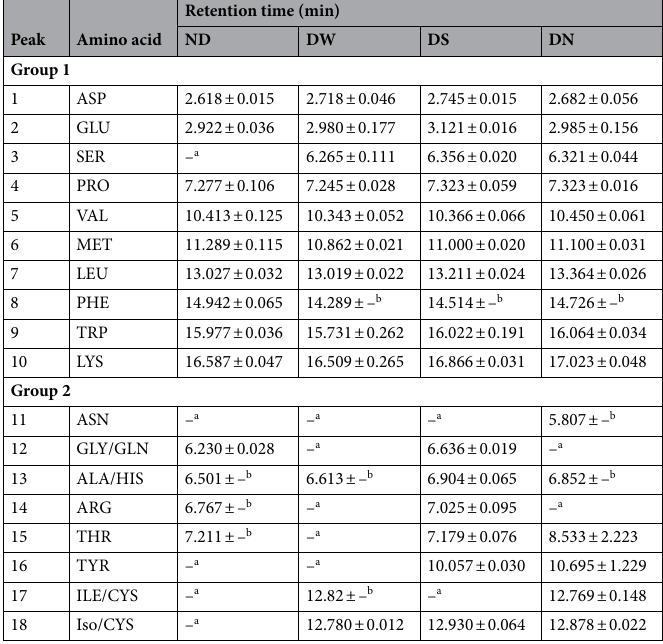
Table 2. Amino acids liberated during dried processes of BSA-Capsaicin nanoparticles. a Not peak was registered. b One peak was